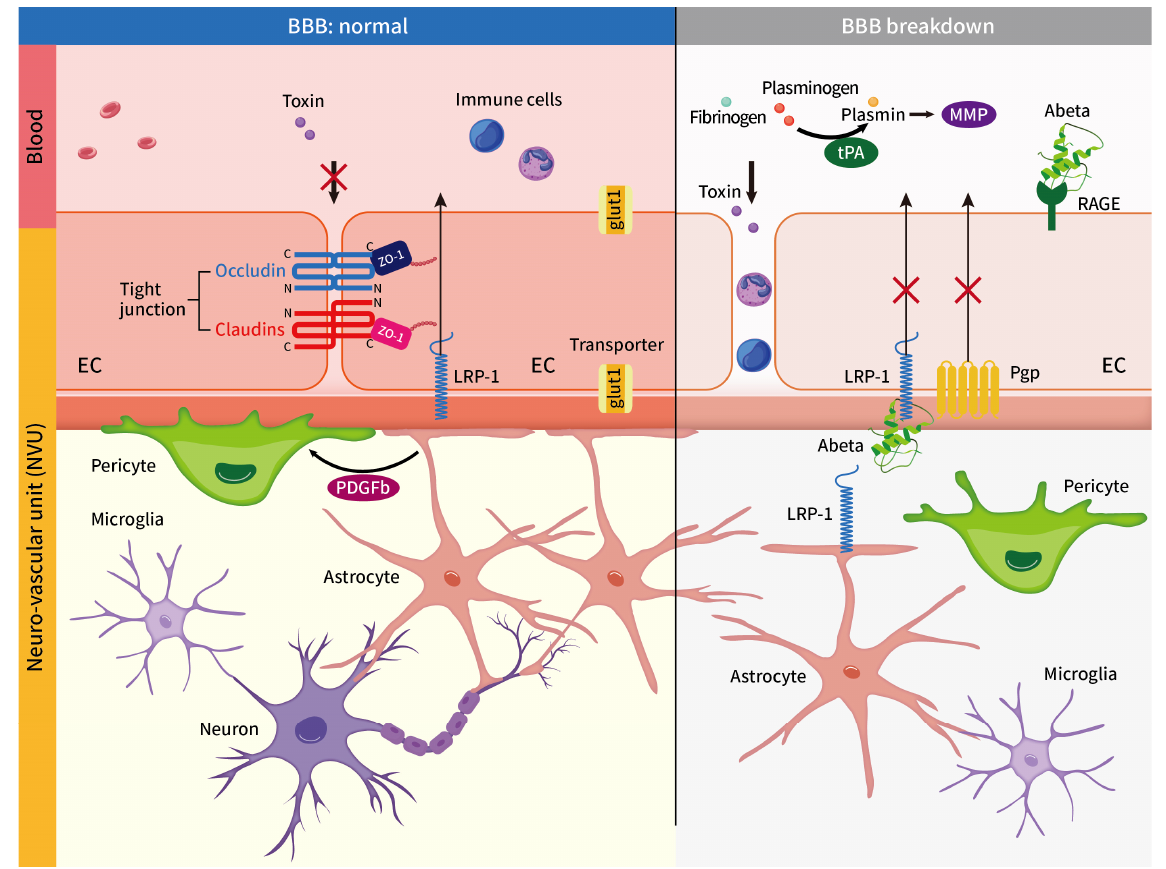
Figure 1. The interaction of differential cells, molecular factors, and transporters in the BBB under physiological (normal) or pathological (BBB breakdown) conditions. (BBB: blood–brain barrier, GLUT1: glucose transporter, LRP1: low-density-lipoprotein (LDL)-receptor-related protein 1, Pgp: phosphoglycolate phosphatase, RAGE: advanced glycosylation end product (AGE) receptor, MMP: matrix metalloproteinase, and PDGFRb: pericytes express platelet-derived growth factor recep- tor